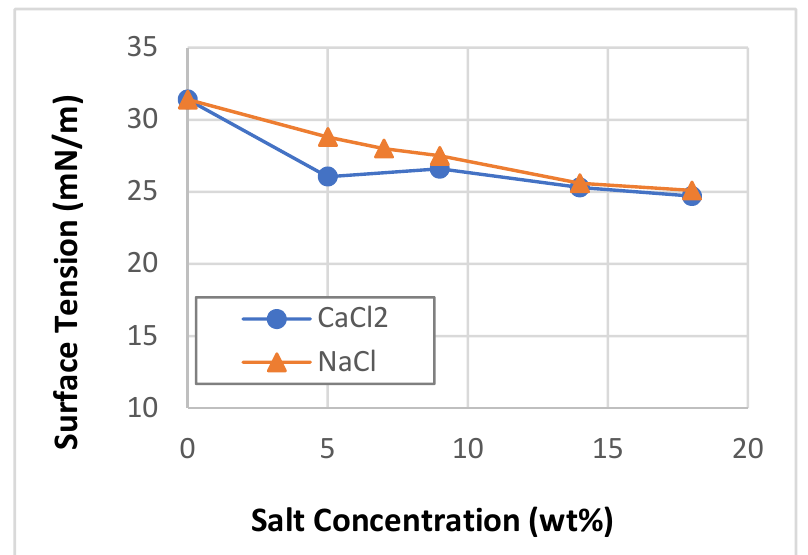
Figure 3. Surface tension of base liquid vs. salt concentration. The effect of salt on the viscosity of the base liquid is shown in Figure 4. The CaCl 2 salt has more effect on the viscosity than the NaCl salt. The increase in the viscosity of the base liquid is expected to be substantial for CaCl 2 salt. Coalescence of the gas bubble occurs when the liquid film lining of each bubble is drained and the gas in the bubble merges to the next bubble. The increase in viscosity of the base liquid reduces the flow of liquid around the bubble and limits the rate of coalescence of bubbles. However, the viscous resistance is not the only limiting factor to be considered in the complex stability of foams. An earlier study [42] on KCL salt showed a reduction in the viscosity of water but also demonstrated a decrease in the coalescence at high salt concentrations.